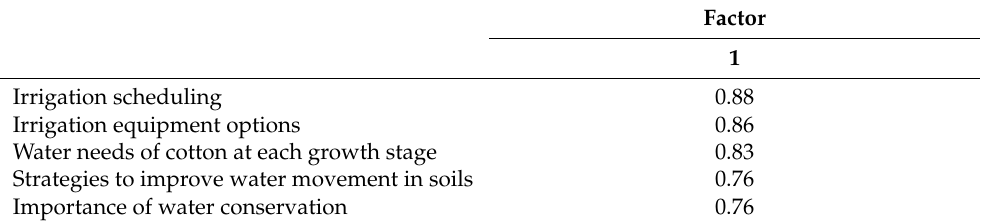
loadings ranging from − 0.33 to 0.43 and explained 77.52% of the variance (see Table 13).